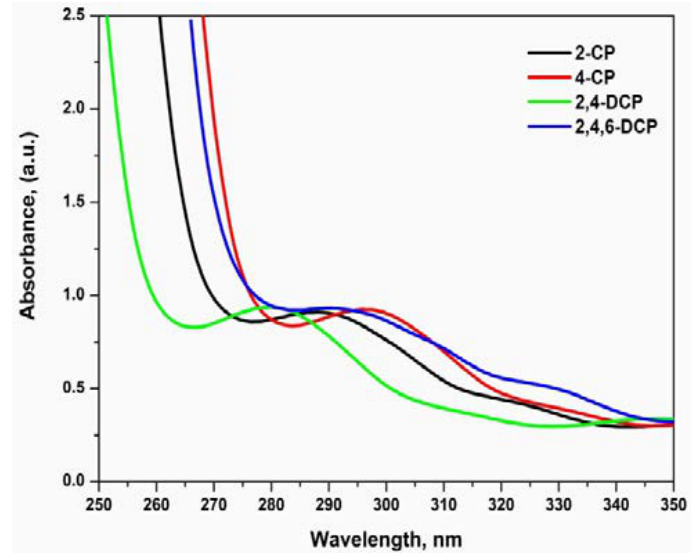
Fig. 8: UV-Vis absorption spectra of 2-CP, 4-CP, 2,4-DCP and 2,4,6-TCP